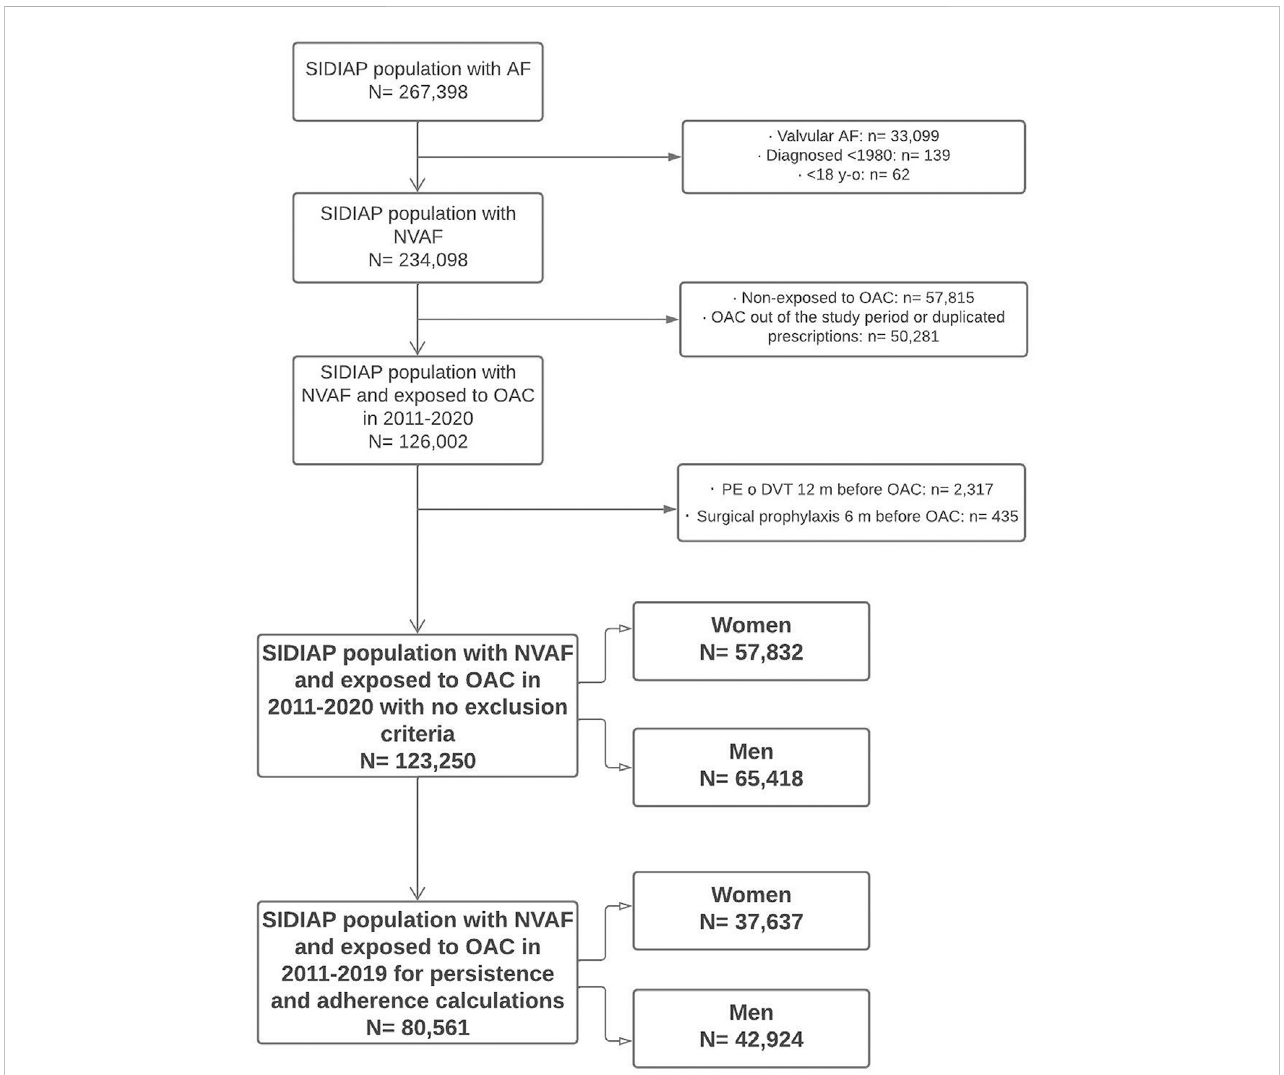
FIGURE 1 Flow diagram ofpopulationincluded. SIDIAP: Information System for Research inPrimary Care. AF,atrial fi brillation;NVAF, non-valvularatrial fi brillation; OAC, oral anticoagulants; PE, pulmonary embolism; DVT, deep vein thrombosis.